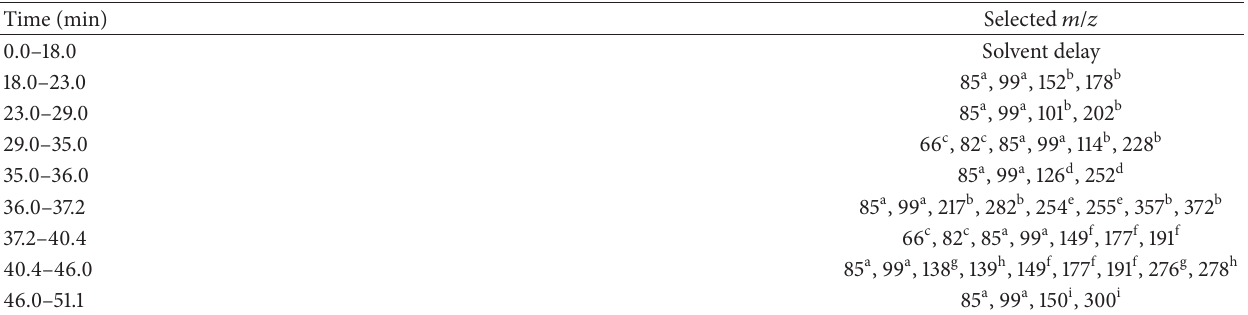
Table 1: Selected ions measured by SIM